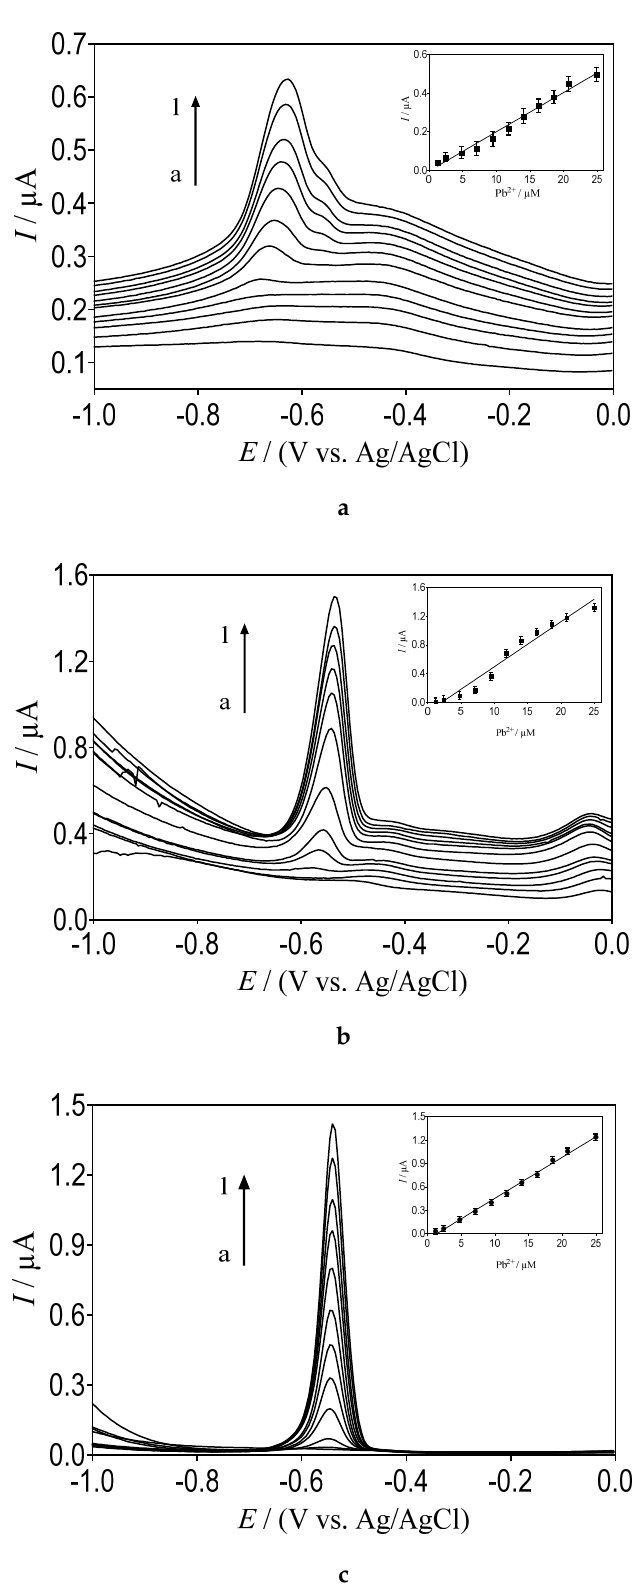
Figure 1. DPASV curves recorded for different concentrations of Pb(II) in ( a ) 0.1 M acetate buffer (pH 4.5), ( b ) 0.5 M NaNO 3 , and ( c ) 0.5 M H 2 SO 4 . Lead concentrations: (a) 0, (b) 1.2, (c) 2.4, (d) 4.8, (e) 7.1, (f) 9.5, (g) 11.8, (h) 14.0, (i) 16.3, (j) 18.6, (k) 20.8, (l) 25 µ M. Inserts: plots of the electrochemical response, in terms of current, as a function of the lead